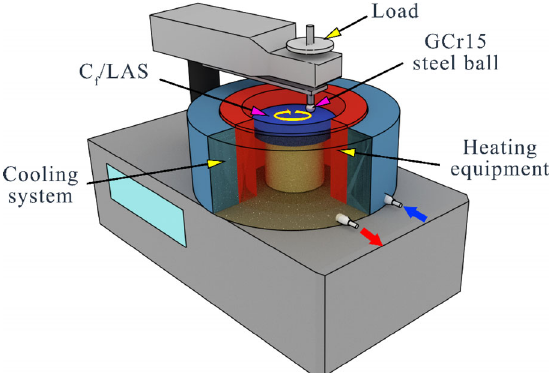
Fig. 2 Schematic of the experimental setup for the tribological test.